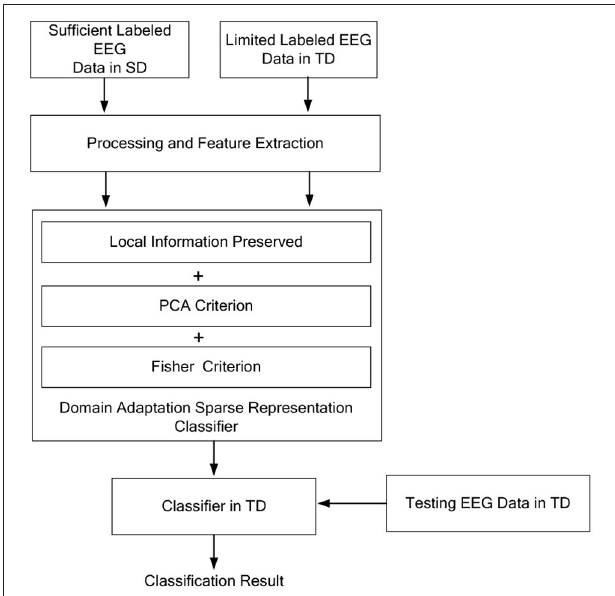
FIGURE 2 | The main idea of the proposed